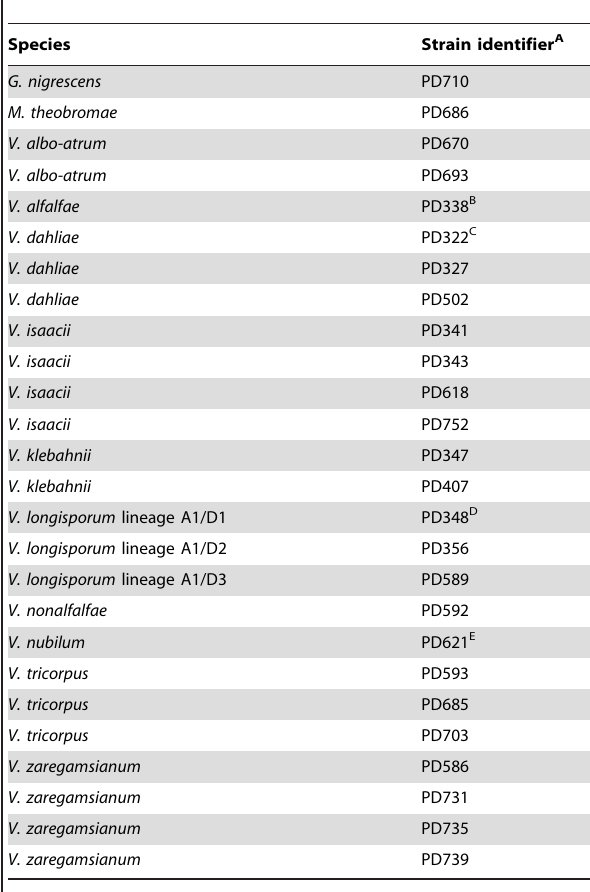
Table 5. Verticillium, Gibellulopsis and Musicillium isolates used to validate the multiplex PCR assays, for details on isolate selection see Materials and